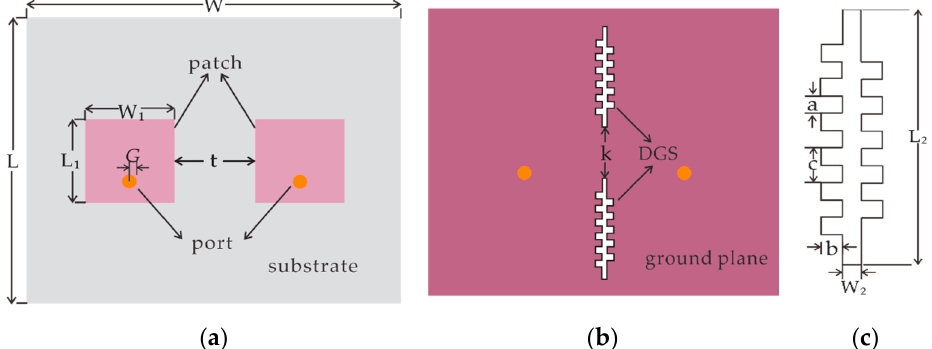
Figure 2. Schematic of the designed multi-input multi-output (MIMO) antenna on a double-side covered with thin metal copper film on the dielectric substrate board. ( a ) Two patches together with common ground plane consisting of microstrip antenna elements on front side; ( b ) Back side with the defected ground structure (DGS) etched on ground plane; ( c ) One zoomed-in zigzag unit where structure dimension marked.